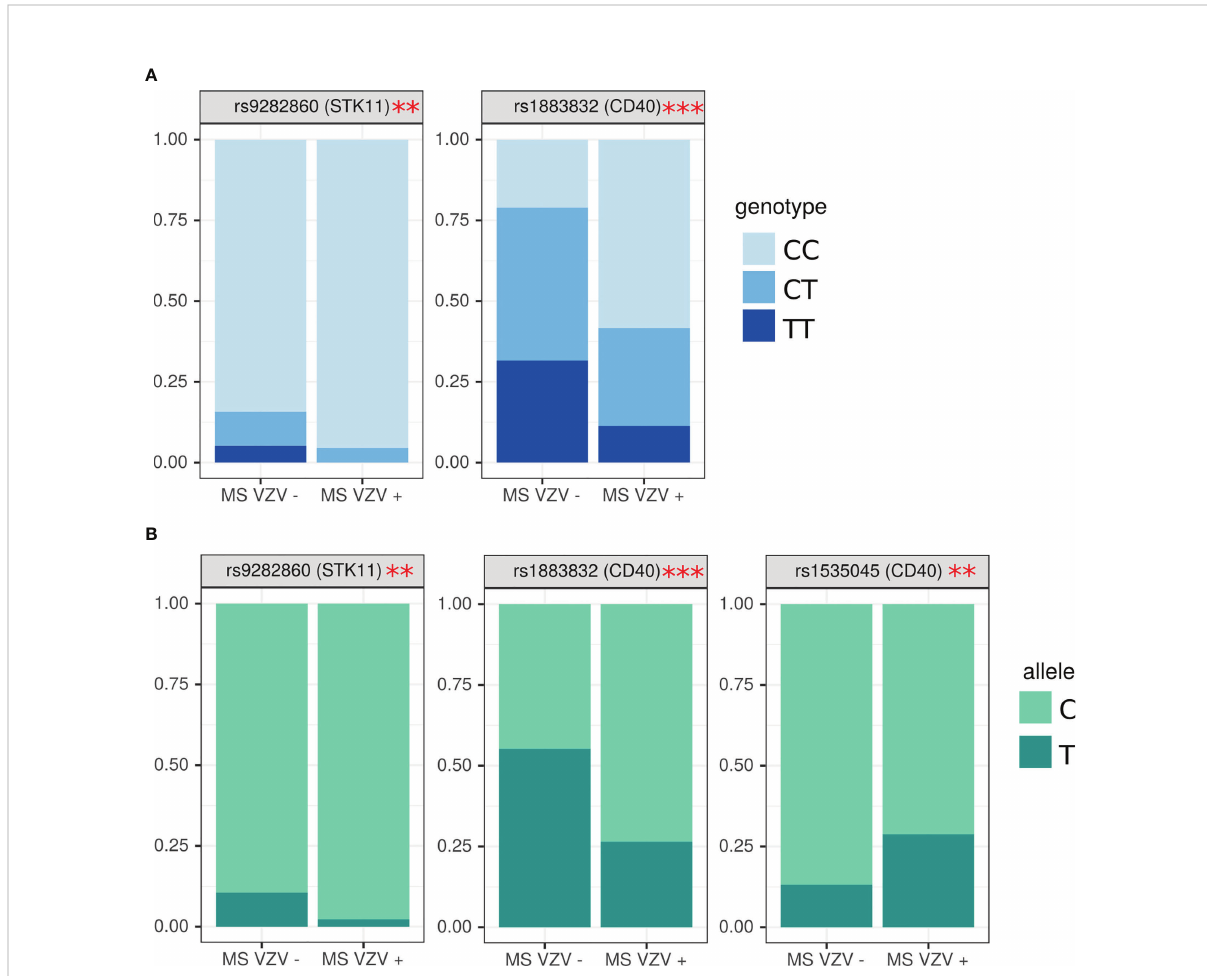
FIGURE 5 Analysis of SNPs genotype and allele frequency based on presence of circulating anti-VZV antibodies. (A) genotypes, (B) alleles. Data is presented as proportion of representation of genotype/allele. There were 151 MS patient samples used for the analysis. The analysis was done using Fisher ’ s exact test. *** - p<0.005, ** -